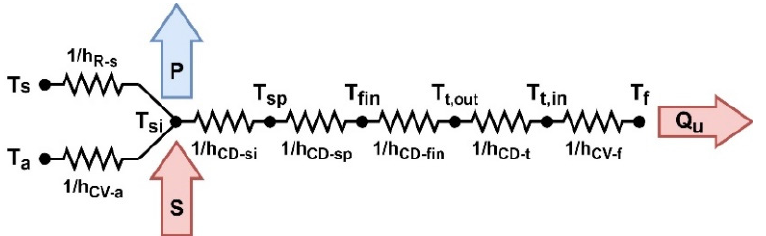
Figure 5. Thermal network for the receiver of the CPV/T collector.